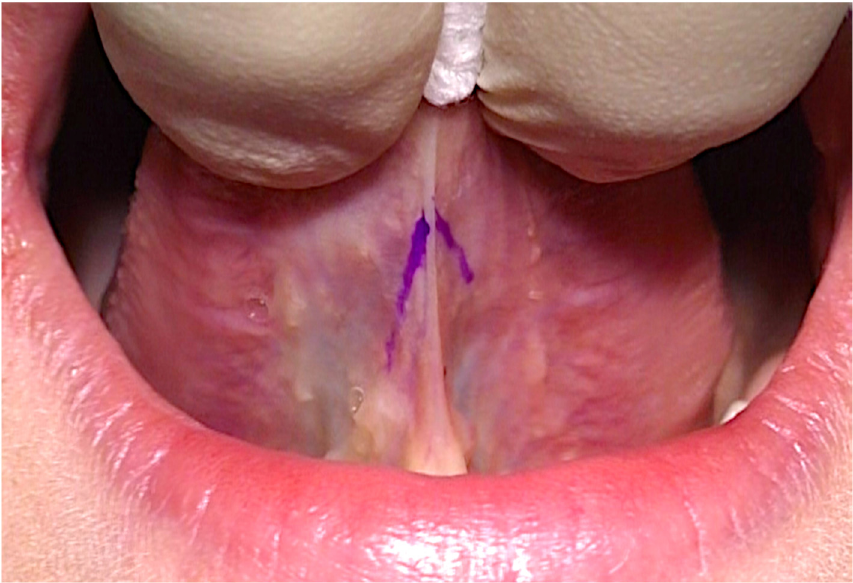
6 of 16 Figure 5. Result after suturing.